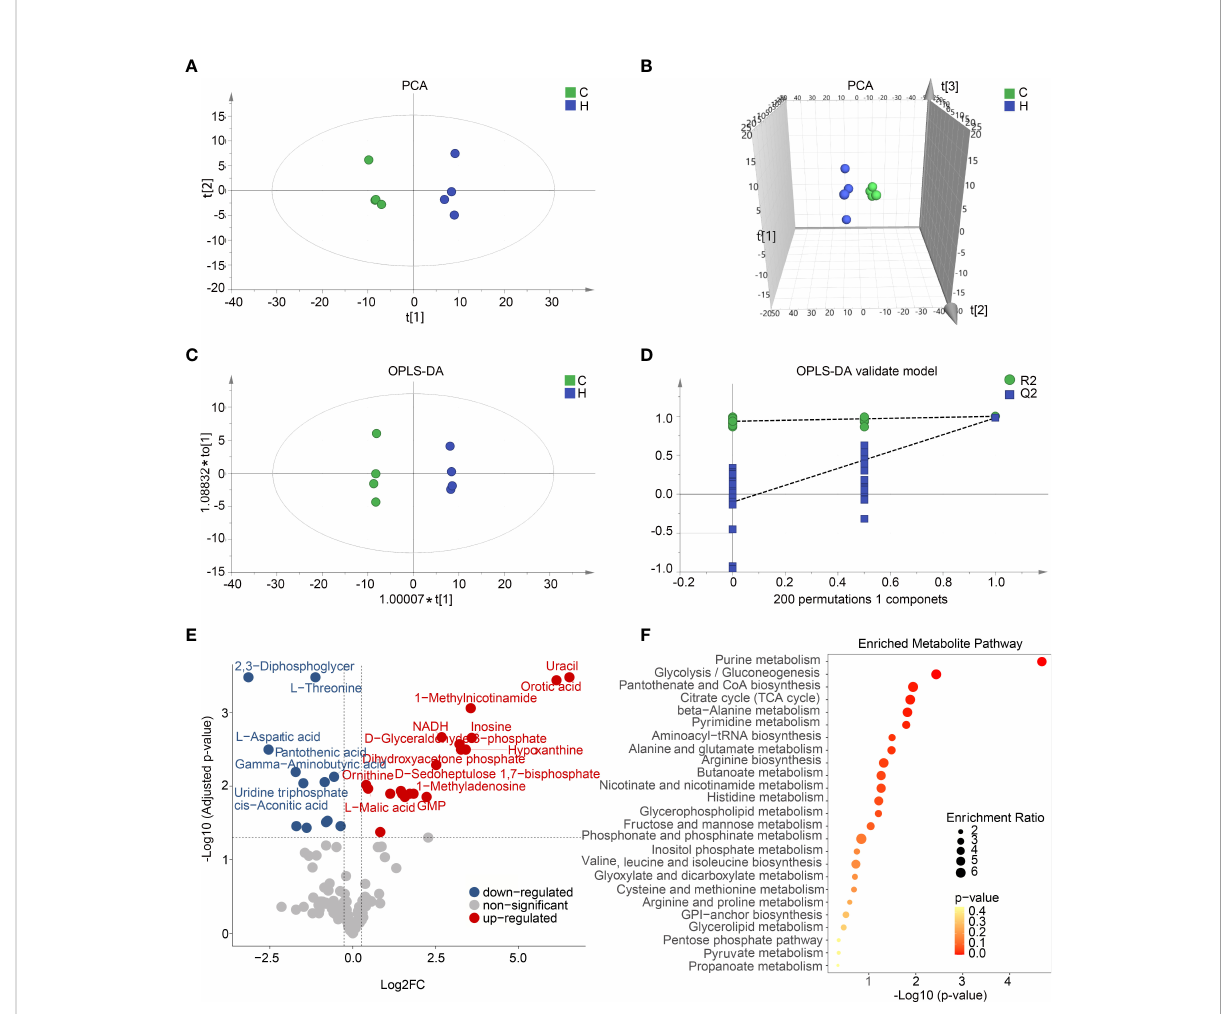
FIGURE 5 Activated microglia in vitro and in vivo with shared metabolic alterations including glycolysis and purine metabolism. (A,B) Two-dimensional (A) and three-dimensional (B) principal component analysis (PCA) score plots displayed a clear trend toward sample separation according activated BV2 cells and control. (C) Orthogonal partial least squares discriminant analysis (OPLS-DA) shows two clusters for activated BV2 cells and control groups. (D) Validation plot of OPLS model using a 200 times permutation test, and the R2-int and Q2-int values were 0.935 and − 0.103, respectively. (E) The volcano plot showed the comparison of cell metabolites response to hypoxia induced microglia activation. The blue and red dots indicate metabolites downregulated and upregulated in hypoxia compared with control, respectively (fold change > 1.2, p < 0.05). (F) Pathway enrichment analysis of top 25 differential metabolites based on Kyoto Encyclopedia of Genes and Genomes